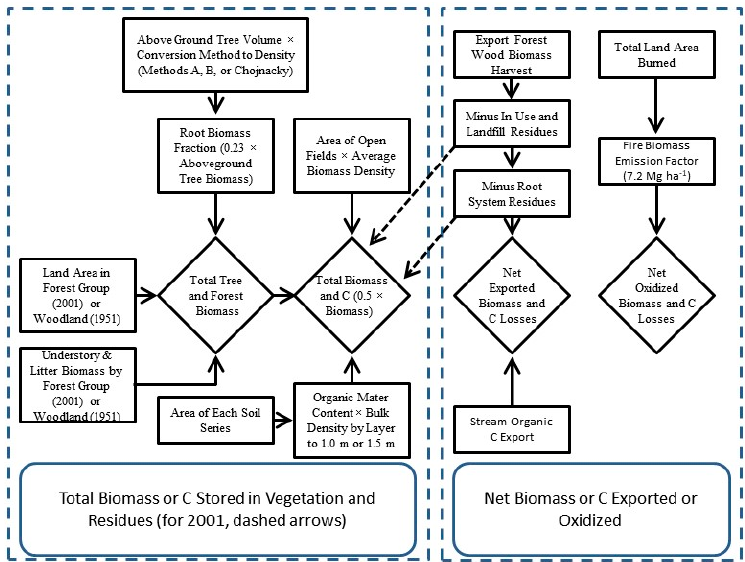
Figure 2. Biome biomass and carbon (C) components in 1951 and 2001 and net biome production in 2001 following Lovett et al. [38]. Described in sections 2.1–2.4 and SM.